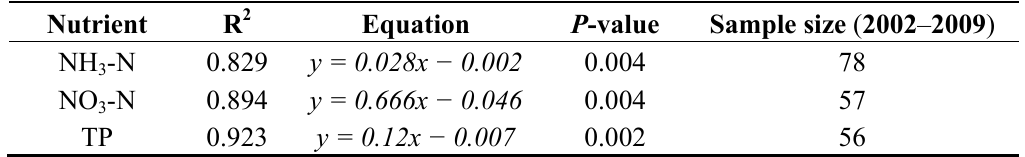
Table 4. Relationship between watershed impervious cover percentage and nutrient loading in Site 2 (Bear Creek watershed, conventional